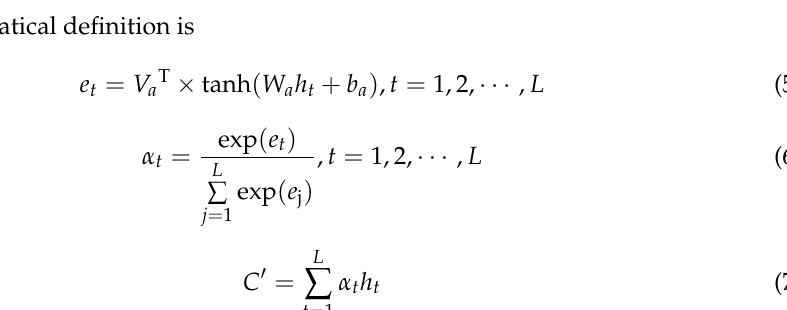
Figure 4. Structure of a tt ention mechanism.